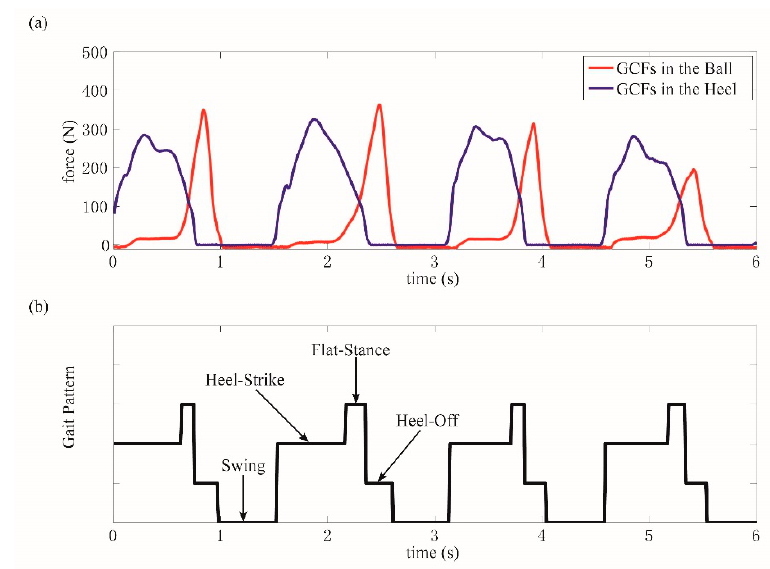
Figure 8. Status division for ball and heel. ( a ) GCFs and status division for the ball, ( b ) GCFs and status division for the heel.